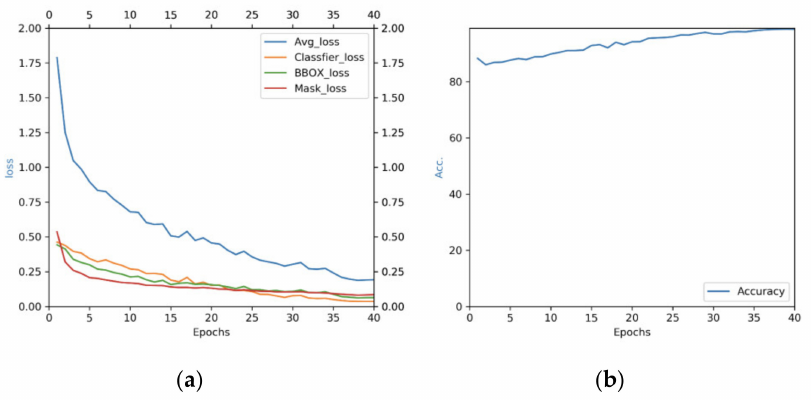
Figure 9. Training curves of ( a ) losses and ( b ) accuracy associated with the best model